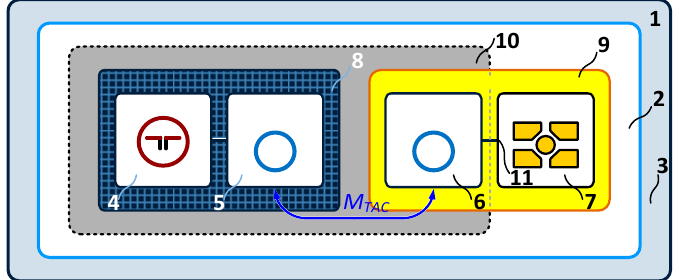
Figure 27. Idea of RFIDtex invention. 1—textronic product with RFID interface; 2—textronic structure; 3—material from which product is made; 4—stitched/embroidered antenna (but also: press-in, welded, glued, etc.); 5—antenna coupling system (made in the same technology as antenna); 6—chip coupling system; 7—RFID chip(s) of di ff erent frequency band; 8—sewn/embroidered antenna module made using techniques existing in the textile industry (by sewing, embroidering, ironing, gluing, welding, etc.); 9—microelectronic module (semi-finished product supplied to the textile industry); 10—antenna system; 11—point of attaching chip to antenna system; M TAC —mutual inductance of inductive coupling.